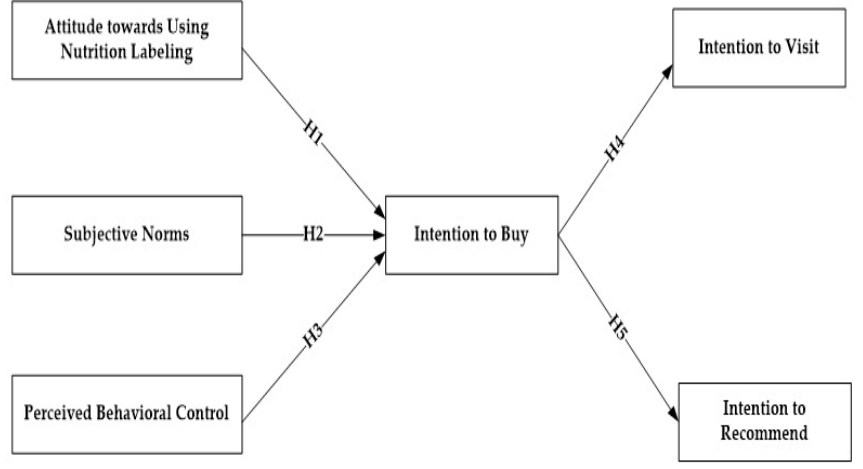
Figure 3. The p roposed research model. Figure 3. The proposed research model.